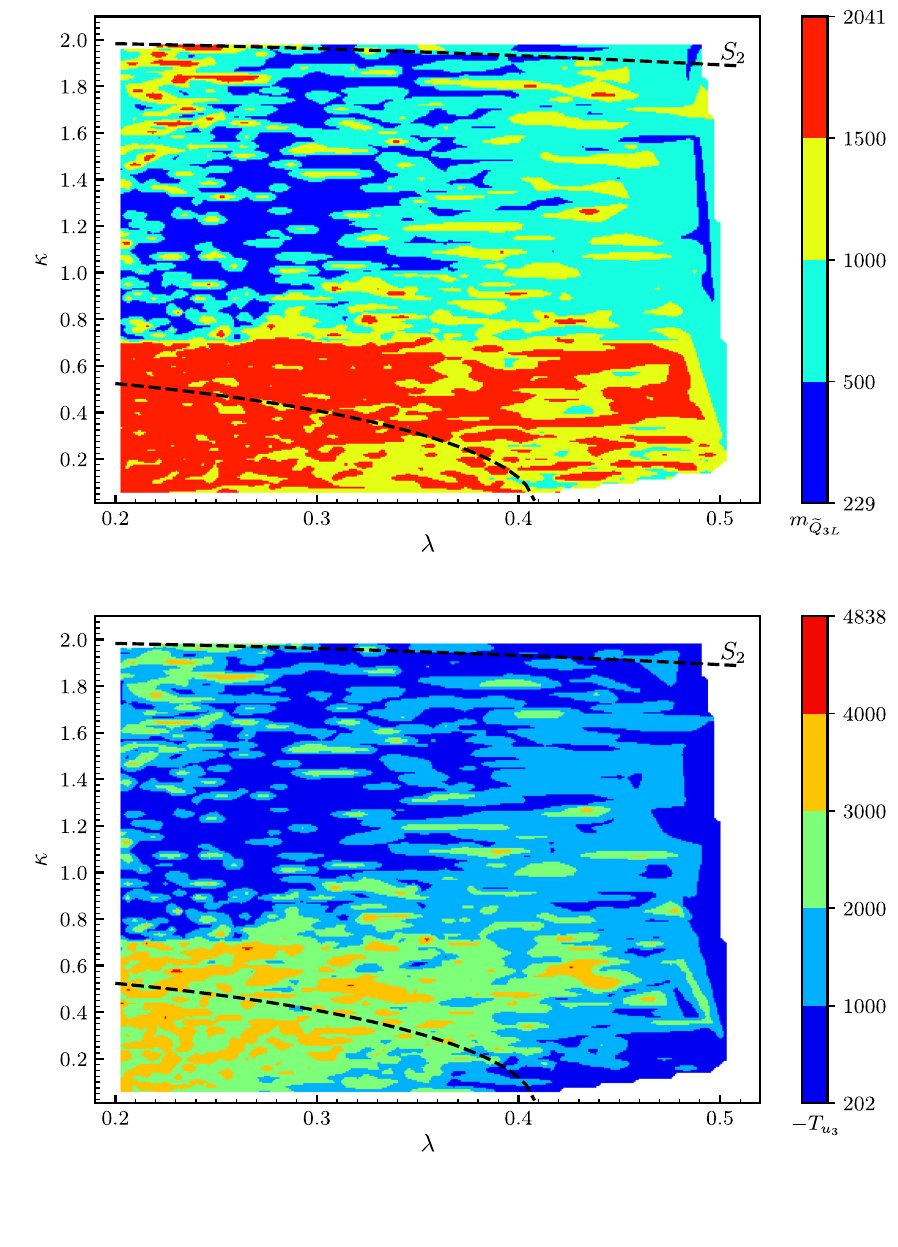
Fig. 28 The same as in Fig. 24, but the colours indicate different low-energy values of the soft masses m (cid:6) Q 3 L